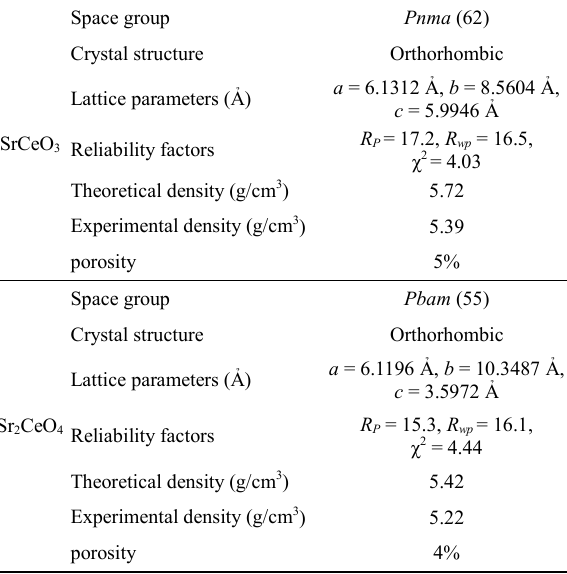
Table 1 Parameters obtained from Rietveld refinement